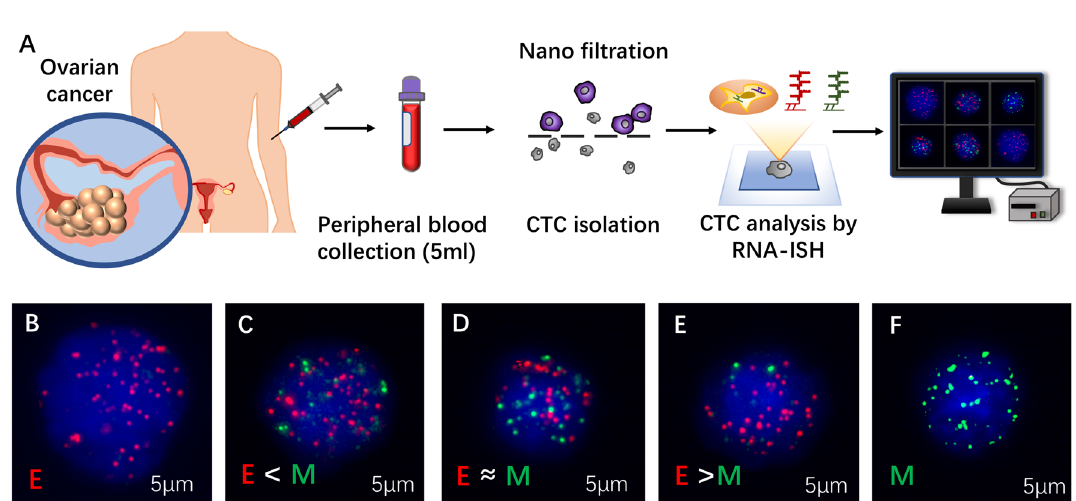
Figure 6. ( A ) Process of circulating tumor cells (CTCs) isolation and detection by CanPatrol CTC enrichment and ISH. ( B – F ) 5 representative images of patients with different CTC subpopulations, based on the RNA- ISH of mesenchymal (vimentin and Twist, green fluorescence) and epithelial (EpCAM and CK8/18/19, red fluorescence)